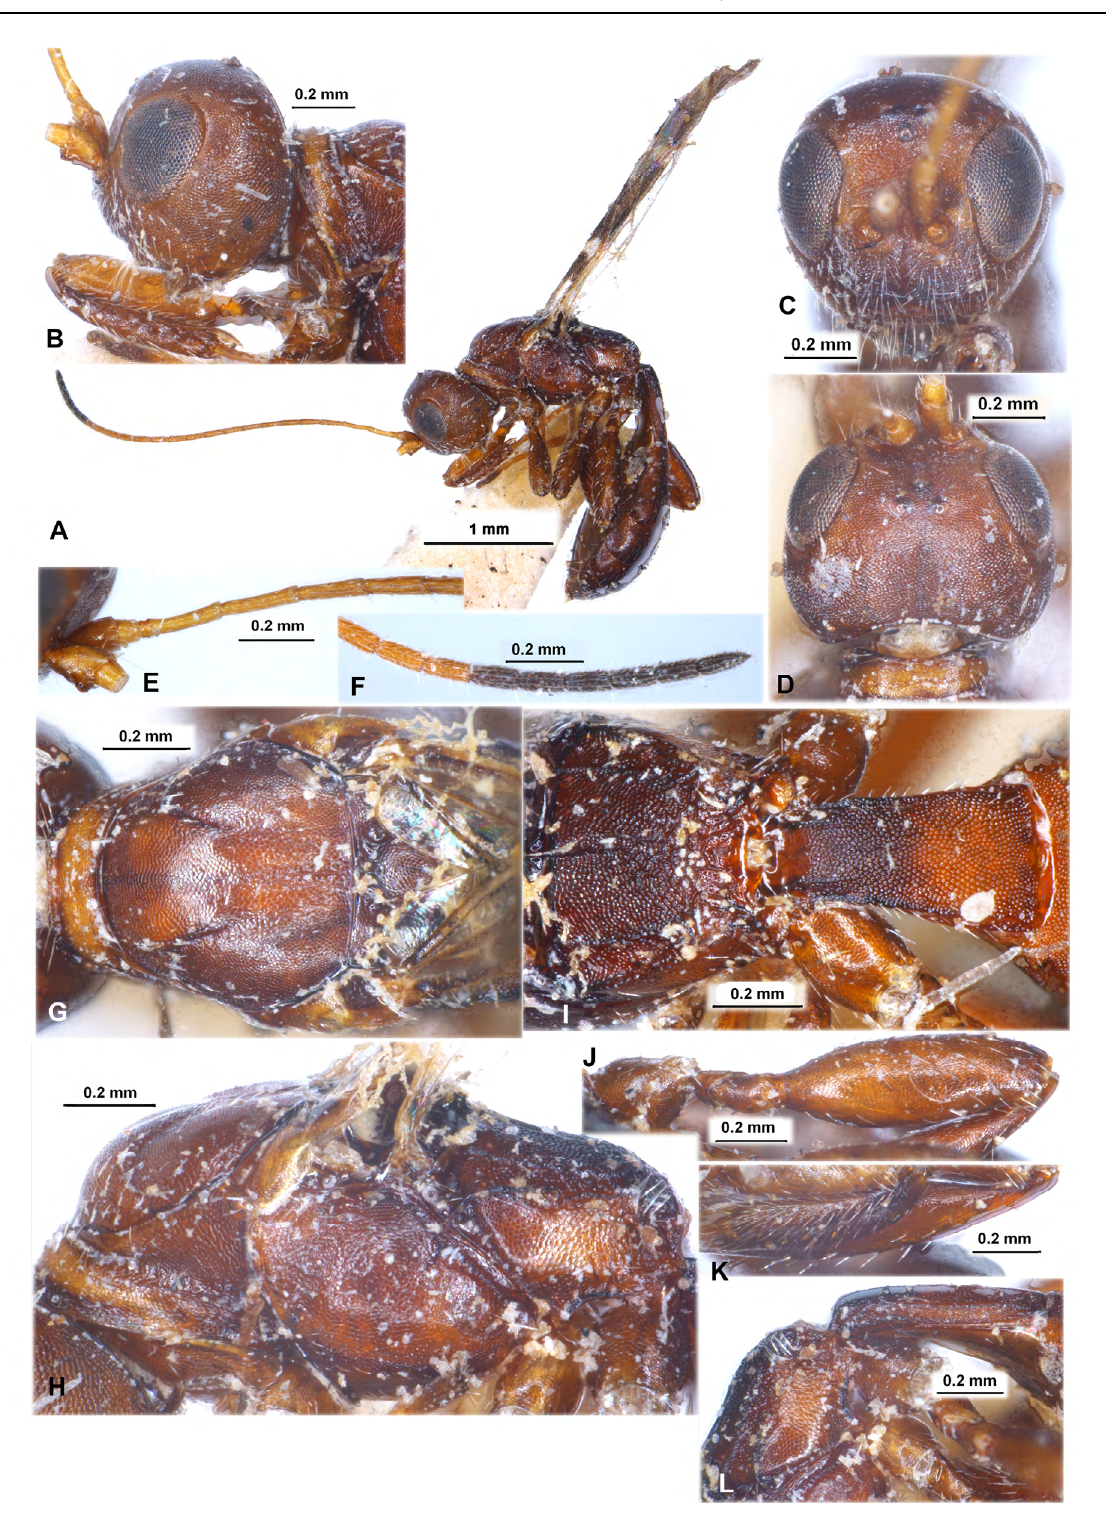
Fig. 28. Platyspathius ( Platyspathius ) pictipennis Viereck,1911, ♂, holotype, USNM. A . Habitus, lateral view. B . Head, lateral view. C . Head, frontal view. D . Head, dorsal view. E . Basal segments of antenna. F . Apical segments of antenna. G . Mesoscutum, dorsal view. H . Mesosoma, lateral view. I . Propodeum and first metasomal tergite, dorsal view. J . Hind coxa and femur, lateral view. K . Hind tibia, lateral view. L . Propodeum and first metasomal tergite, lateral